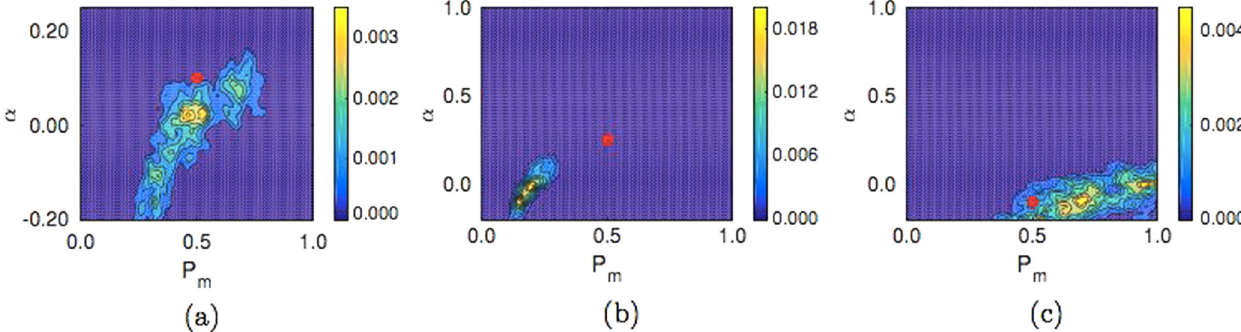
Fig. 3 Posterior distributions for simulations of the realistic experiment described using the PCF as a summary statistic for an ABM of dimension L x = 23 and L y = 23. The synthetic data is generated from fi ve replicates of the ABM. a Model A: P m = 0.5, α = 0.1, b model B: P m = 0.5, = 0.5, α = − 0.1. In all cases the red dot indicates the value of the parameters used to generate synthetic α = 0.25, c model B: P m